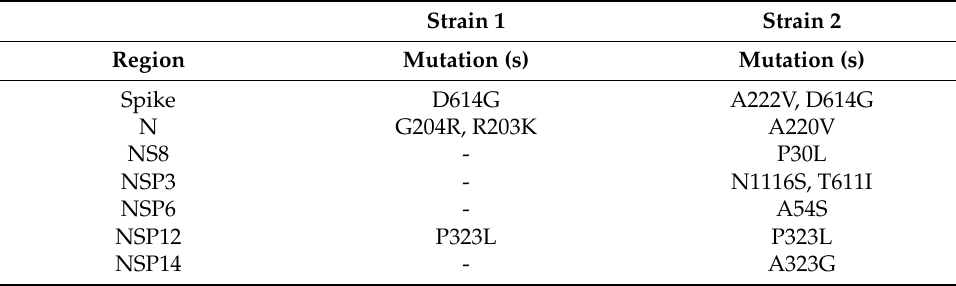
Figure 1. Phylogenetic analysis of SARS-CoV-2/human/ITA/APU-POLBA21/2020 and SARS-CoV-2/human/ITA/APU-POLBA20/2021. Other genomes were retrieved from GISAID (https://www.gisaid.org, accessed on 14 February 2021). Clade information using the GISAID and Nextstrain nomenclatures is shown. The strains of the present study are underlined in red. Table 1. List of mutations of the SARS-CoV-2/human/ITA/APU-POLBA21/2020 strain identified in the first infection (Strain 1) and the SARS-CoV-2/human/ITA/APU-POLBA20/2021 strain identified in the second infection (Strain 2).